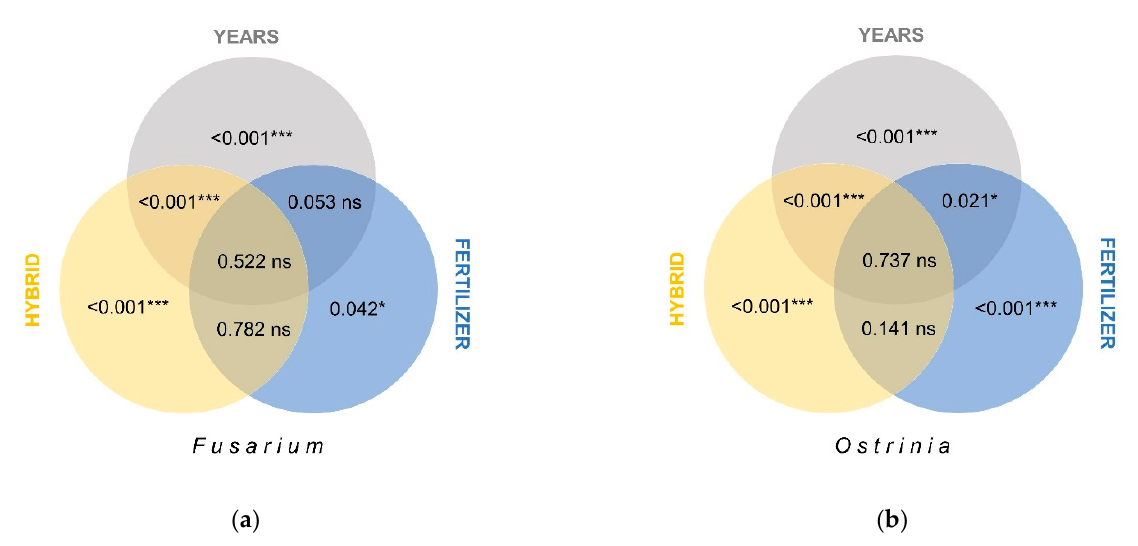
Figure 5. Venn diagram depicting the influence of experimental factors and their interaction on maize crop health: ( a ) Fusarium sp. incidence; ( b ) Ostrinia nubilalis incidence. Numbers represent p -values according to three-way ANOVA results; significance levels assigned p > 0.05 (ns), p < 0.05 (*), p < 0.001 (***).